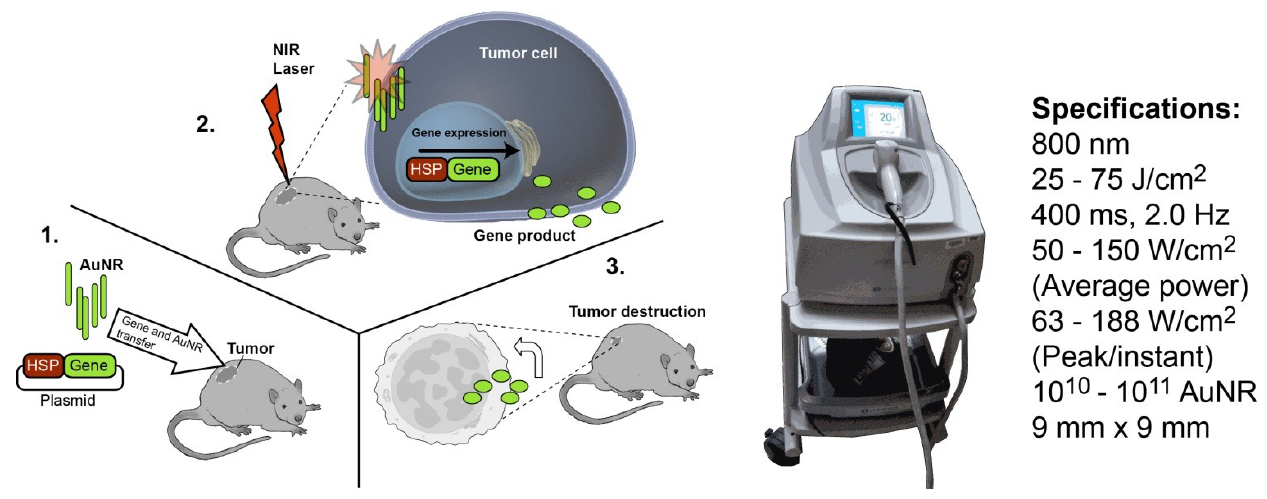
Figure 1. Schematic showing near infrared (NIR)-driven hyperthermia mediated therapy. (1) AuNRs complexed with therapeutic HSP70B promoter-driven gene vectors will be injected into mice intratumorally or intravenously with targeting moieties; (2) NIR laser treatment of the tumor site will result in localized heating of the AuNR, which in turn will induce expression of the therapeutic gene; (3) The predicted end result is tumor growth inhibition and tumor mass reduction. The Light Sheer ET Lumenis FDA-approved NIR laser light source and machine specifications are shown to the